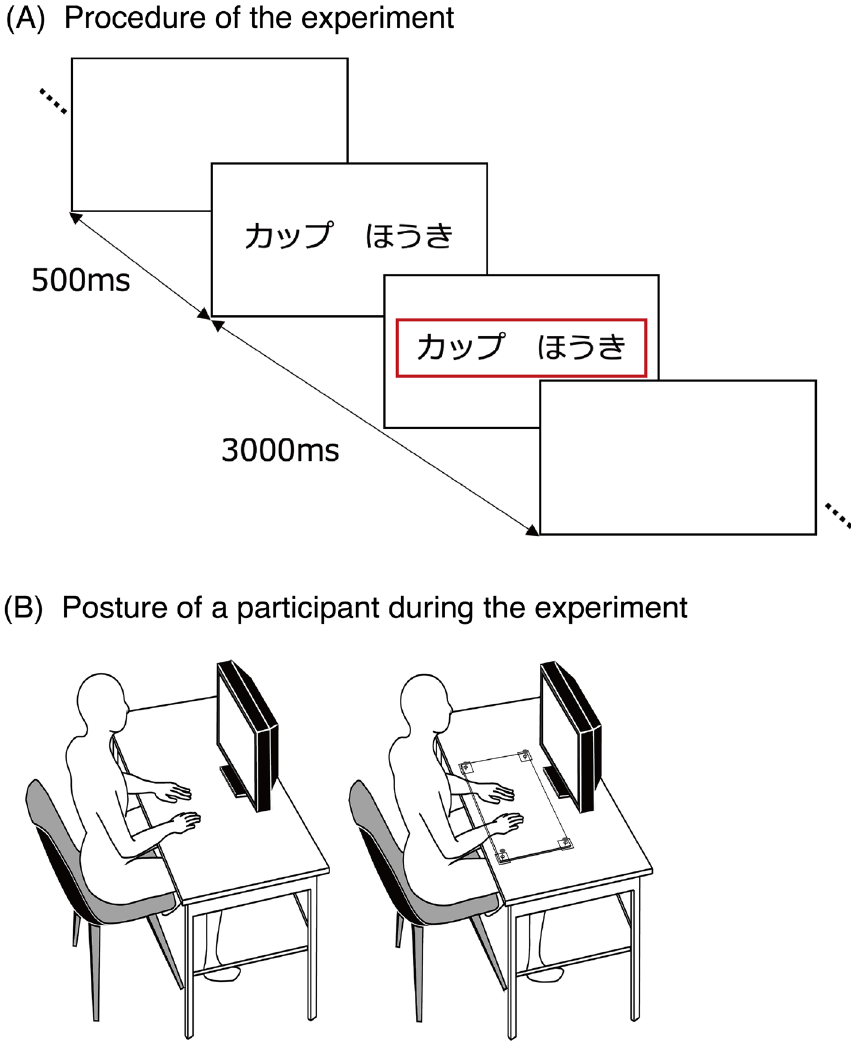
two words are cup and broom. A red frame appeared around the words after the voice response. After 3,000 ms elapsed from initial presentation of the words, a blank screen was presented, followed 500 ms later by the next pair of words. ( B ) Experimental conditions. Left: no constraint condition, right: hand-constraint condition. In the hand constraint condition, hand movements were restrained by a transparent acrylic board. To reduce participant fatigue, separate sessions for each condition were conducted on different